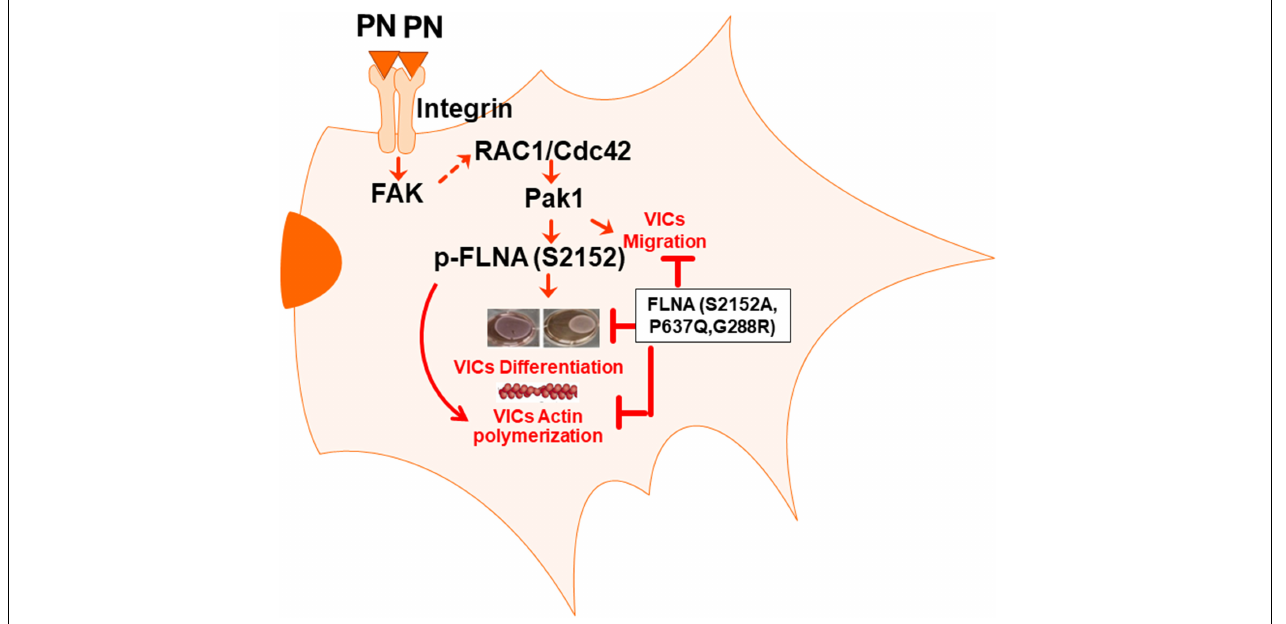
FIGURE 8 | Model for the role of PN/ α 5 β 1 integrin-mediated Fak-Rac1-Cdc42-Pak1-FLNA signaling in VIC survival and remodeling functions. The figure summarizes our findings in a model that proposes how periostin and FLNA function as a central regulatory axis for valve morphogenesis. Overall, we conclude that a PN/ α 5 β 1 integrin interaction with FLNA engenders a unique signaling pathway that is transduced through the activation of Fak1/S6K signaling to Cdc42-Pak1-dependent activation of FLNA ( Figures 1–7 ). This results in changes in adhesion and cytoskeletal organization that are linked to morphogenetic remodeling and maturation of valve